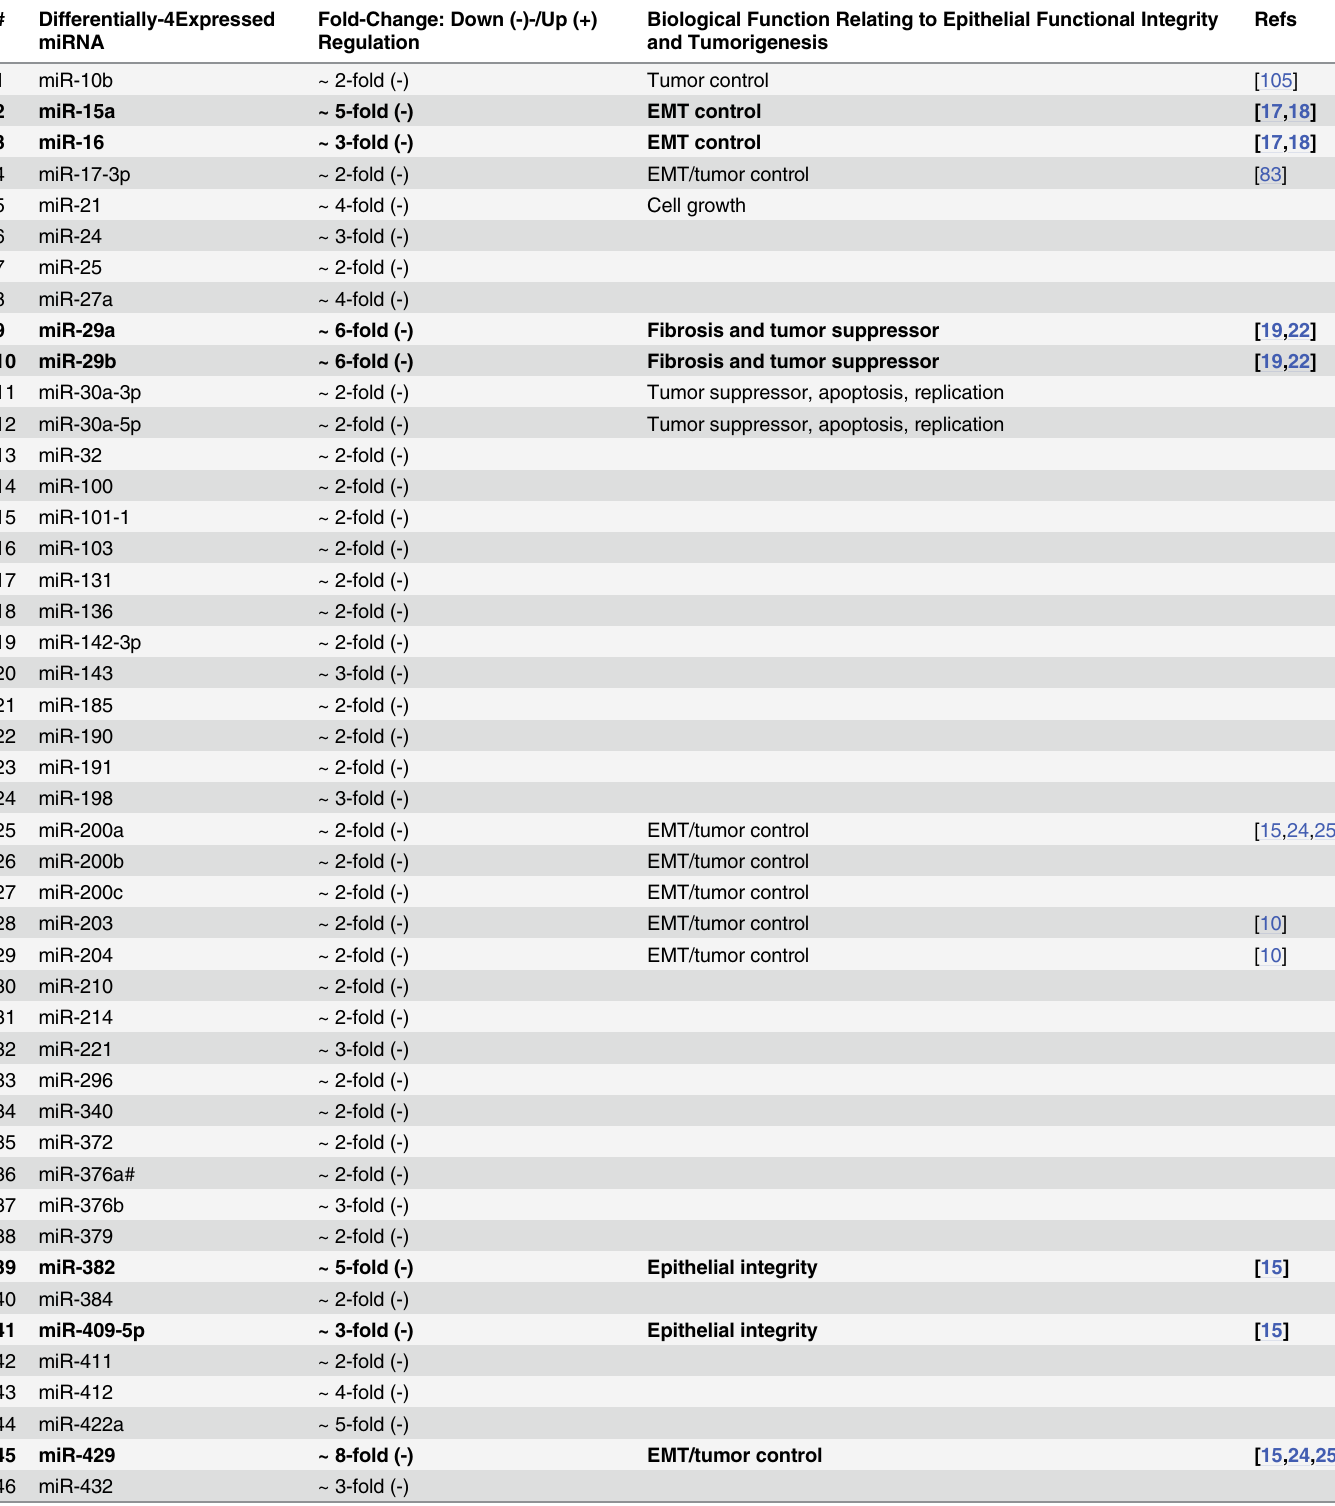
Table 1. Chlamydia -Induced Sustained Differentially Expressed miRNAs (http://www.microrna.org/microrna/home.do;